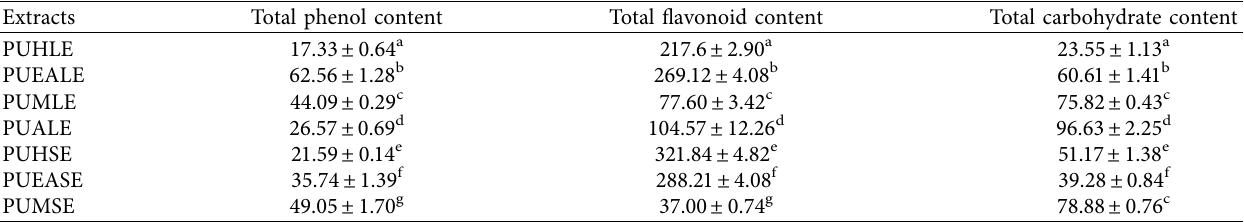
Used in Table 2 are as follows: (PUHLE: P. utilis hexane leaf extract, PUEALE: P. utilis ethyl acetate leaf extract, PUMLE: P. utilis methanol leaf extract, PUALE: P. utilis aqueous leaf extract, PUHSE: P. utilis hexane seed extract, PUEASE: P. utilis ethyl acetate seed extract, PUMSE: P. utilis methanol seed Table 3: Results for the total phenol, flavonoid, and carbohydrate content of p. uilis leaf, and seed, extracted in different solvents. Extracts